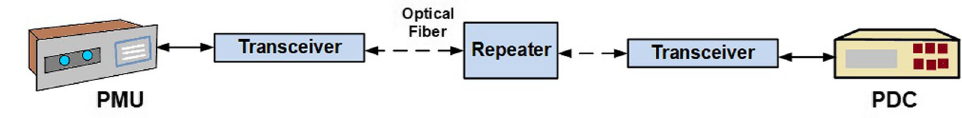
Fig. 8 Optical Fiber Synchrophasor Communication System